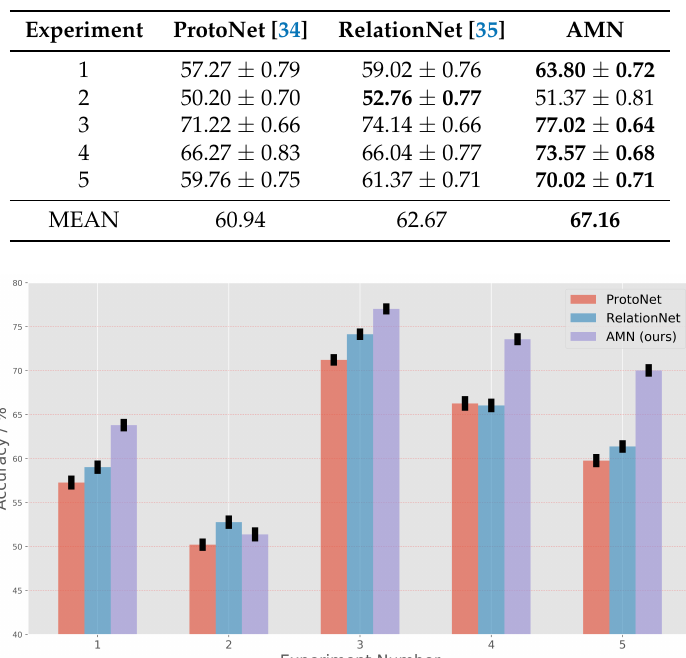
Table 2. Average accuracy(%) and 95% confidence interval(%) of ProtoNet, RelationNet and AMN on the NWPU-RESISC45 dataset, each experiment contains 600 randomly selected tasks. The best results on each experiment are marked in bold.